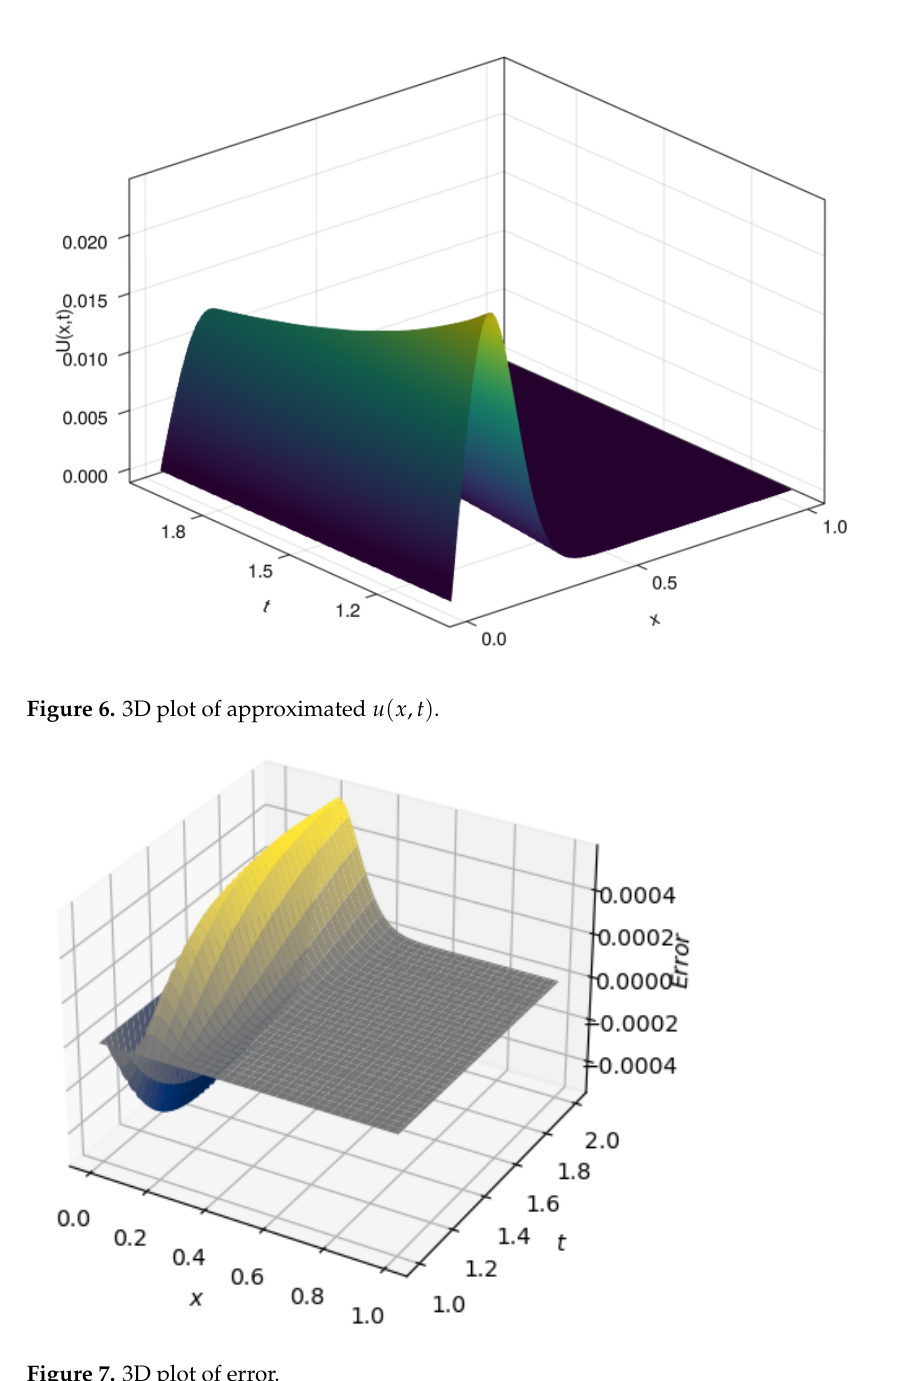
Figure 7. 3D plot of